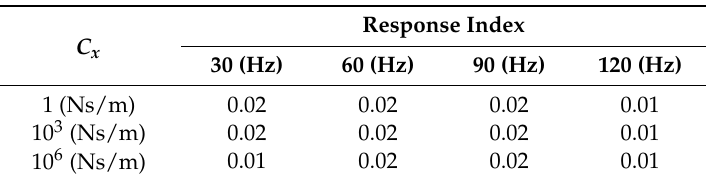
Table 5. Theoretical response index from frequency response functions for different damping coefficients ( K x = 43,990